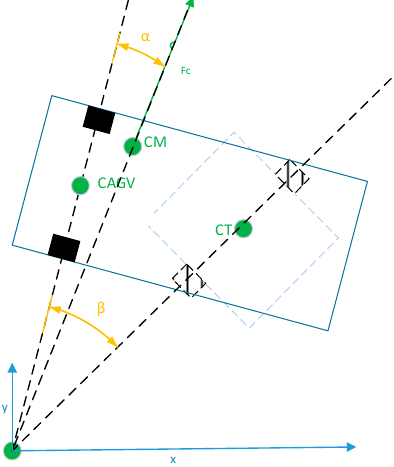
Figure 18. Direction of application of centrifugal force (angle α ).